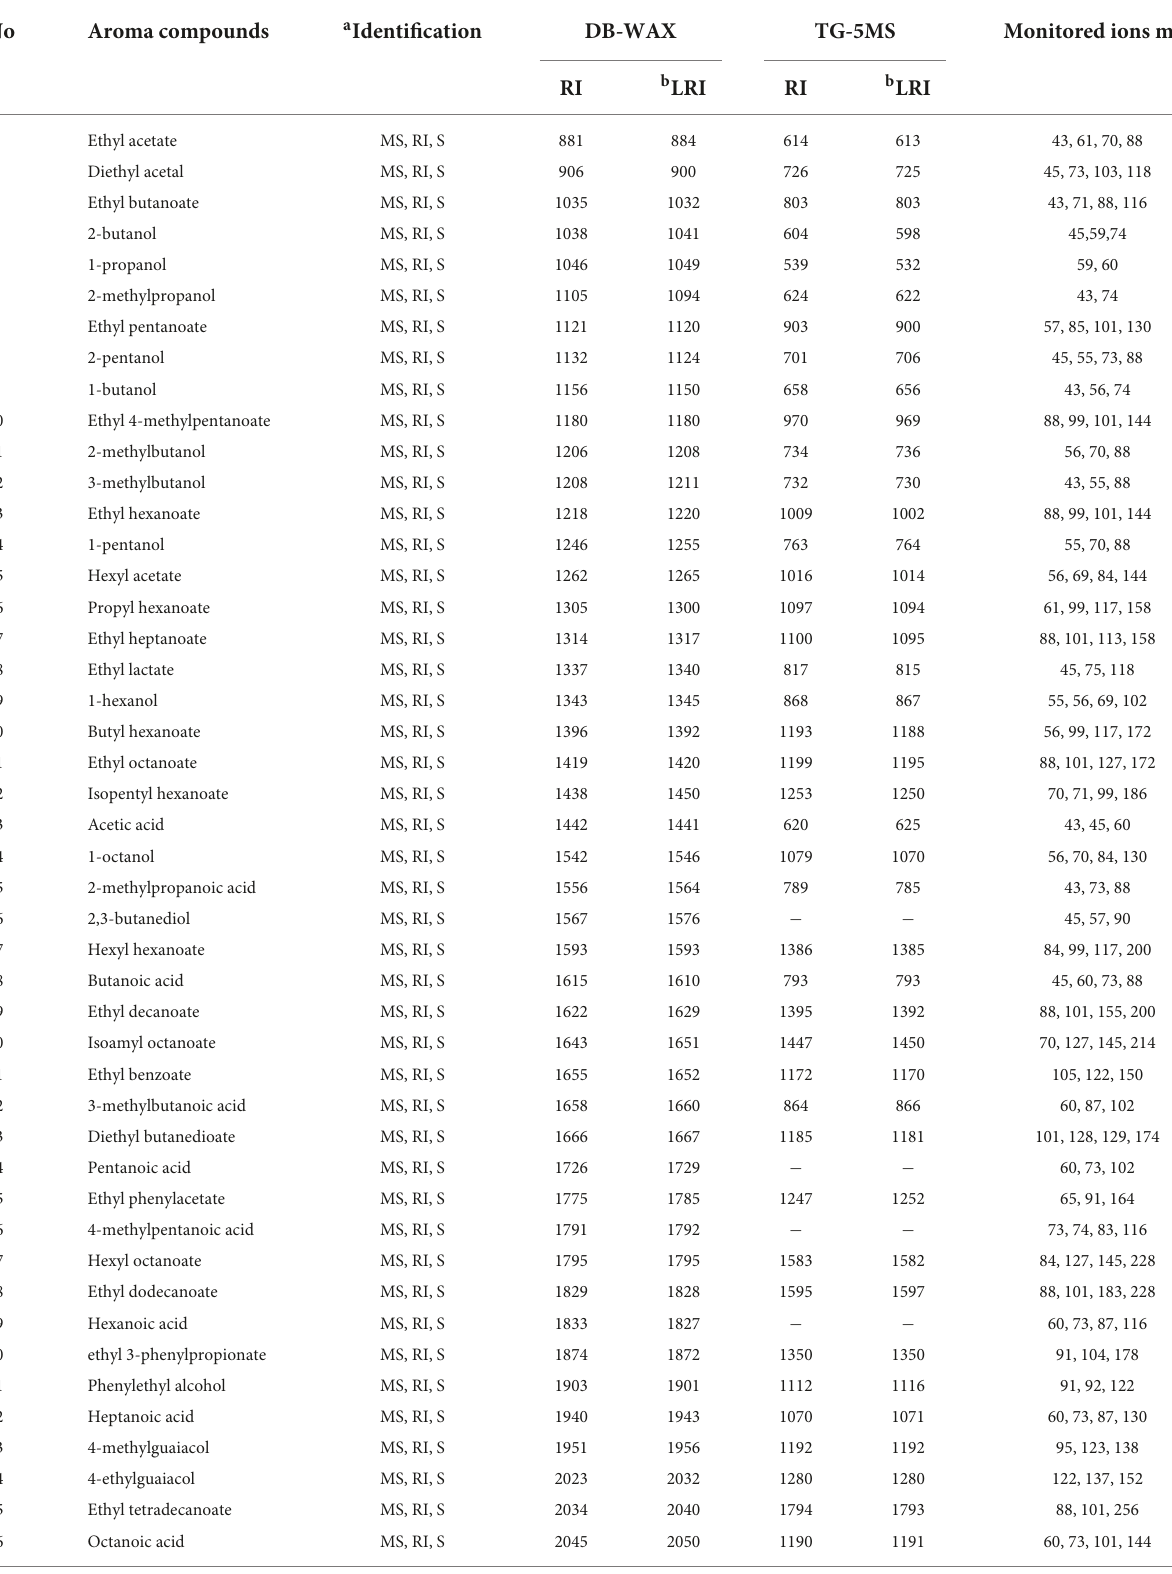
TABLE 1 Aroma compounds identified by gas chromatography-mass spectrometry (GC-MS) in four grades of strong-aroma types of base Baijiu (base